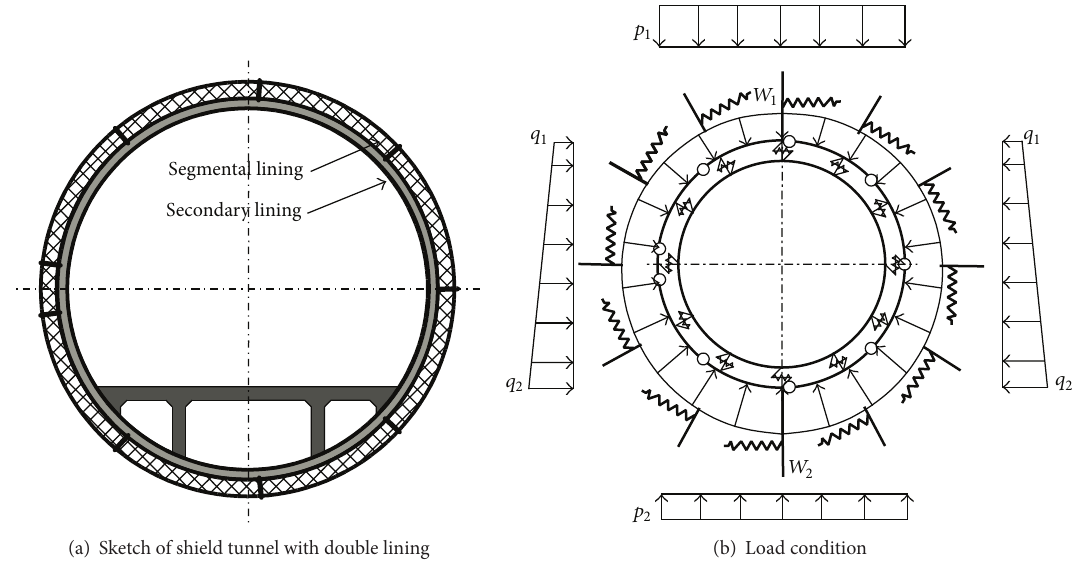
Figure 11: Schematic diagram of double linings and its load